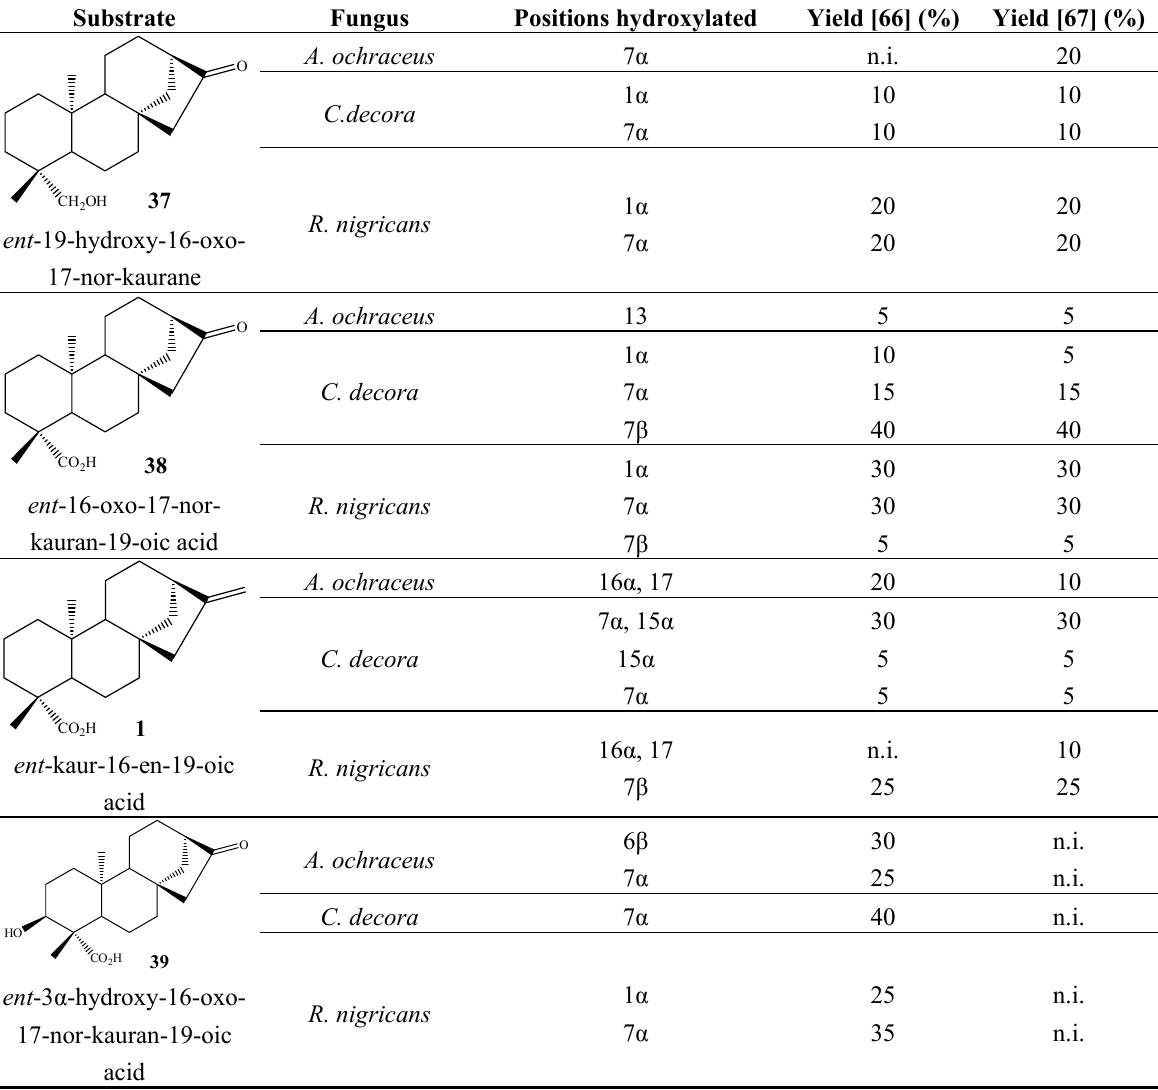
Table 3. Comparison on the yields obtained by Beilby et al. [66] and Ghisalberti et al. [67].